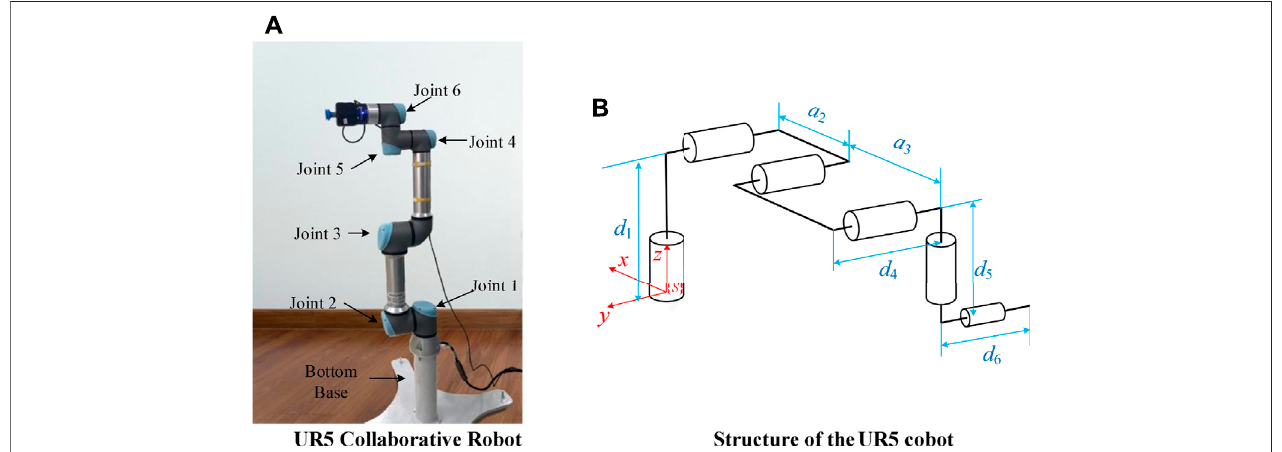
FIGURE 4 | The solid and structure of the UR5